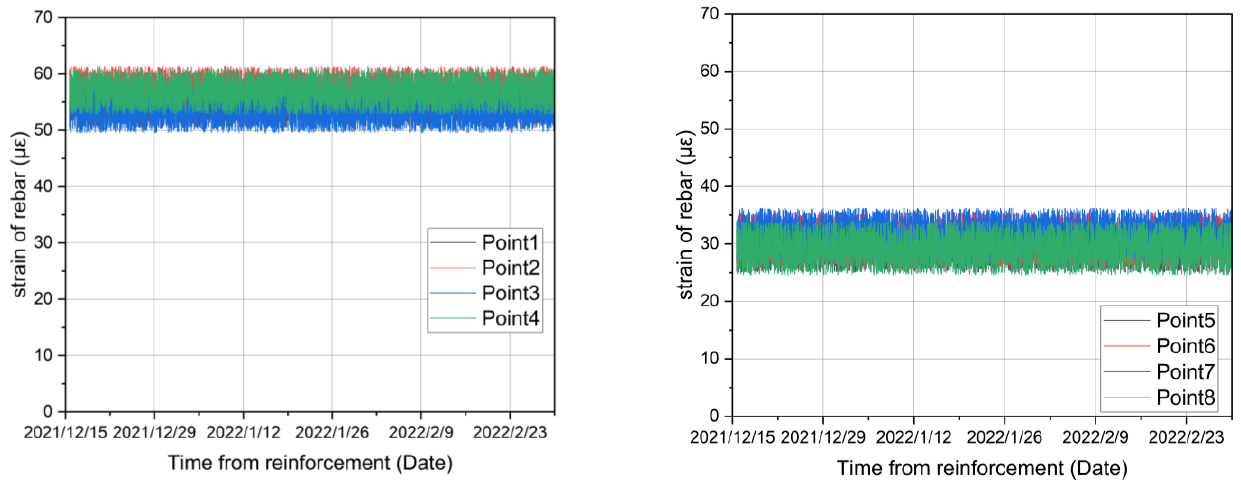
Figure 11. Rebar strain.